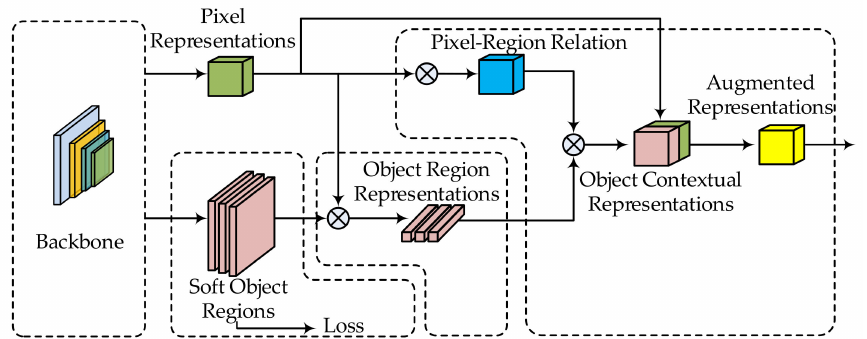
Figure 4. The structure of the OCR